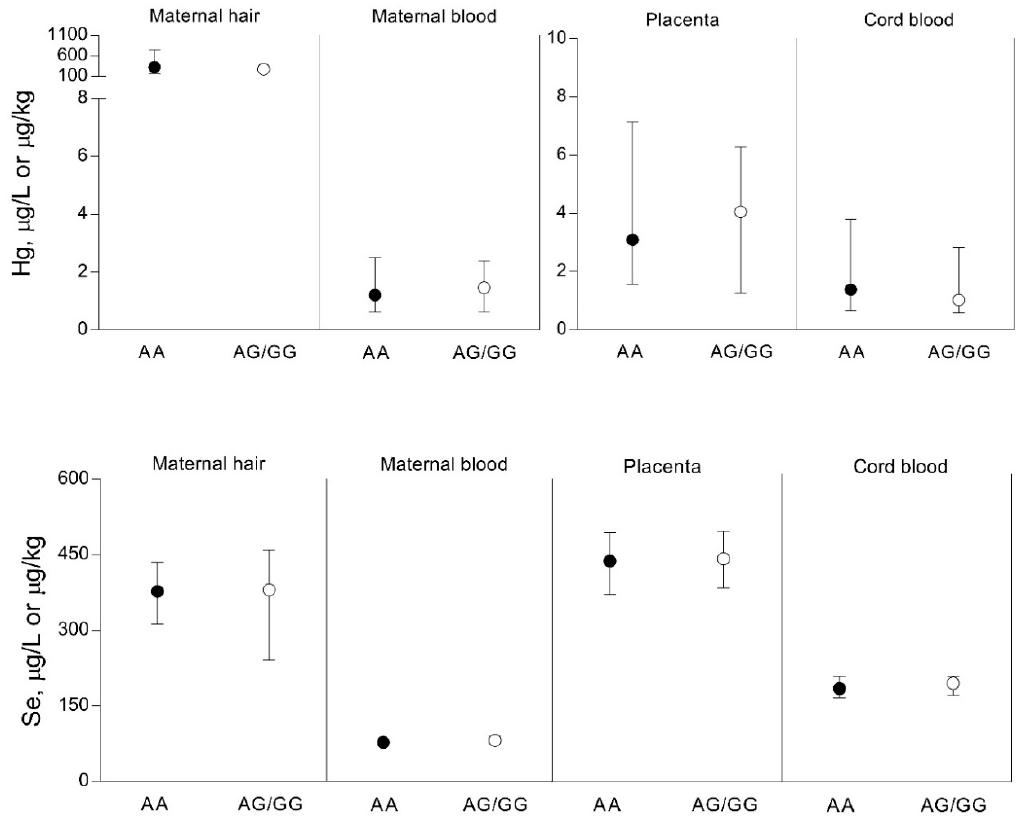
Figure 4. Concentrations of metallothionein (MT2) in maternal serum in a part of the study participants (only subjects from coastal Croatia, n = 94) related to the frequency of seafood (fish) consumption per week. Subgroups: 0—no consumption ( n = 4); 1—consumption ≤ 1 per week ( n = 38); 2—consumption > 1–2 per week ( n = 31); 3—consumption > 2 per week ( n = 21). Data are presented as the median and interquartile range (25–75%).